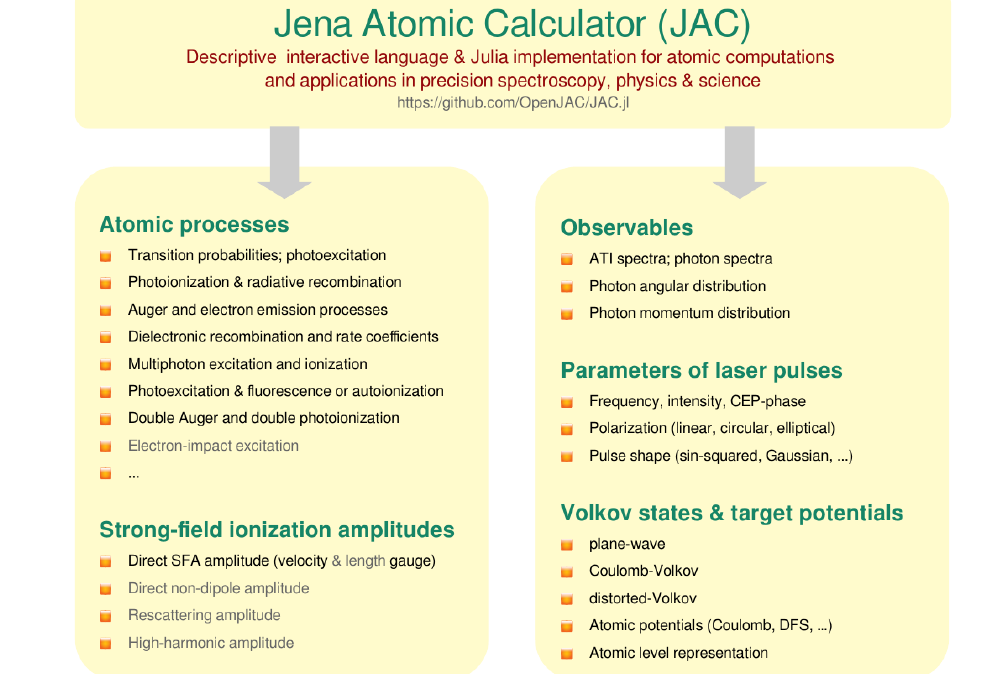
Figure 2. Selected applications of the J AC toolbox that help calculate atomic structures and processes as well as strong-field ionization amplitudes in various approximations. Apart from choosing between typical strong-field observables, the Volkov states and the parameterization of the laser pulses can be controlled rather flexibly. See Refs. [16,25] for a detailed account of all other features of this